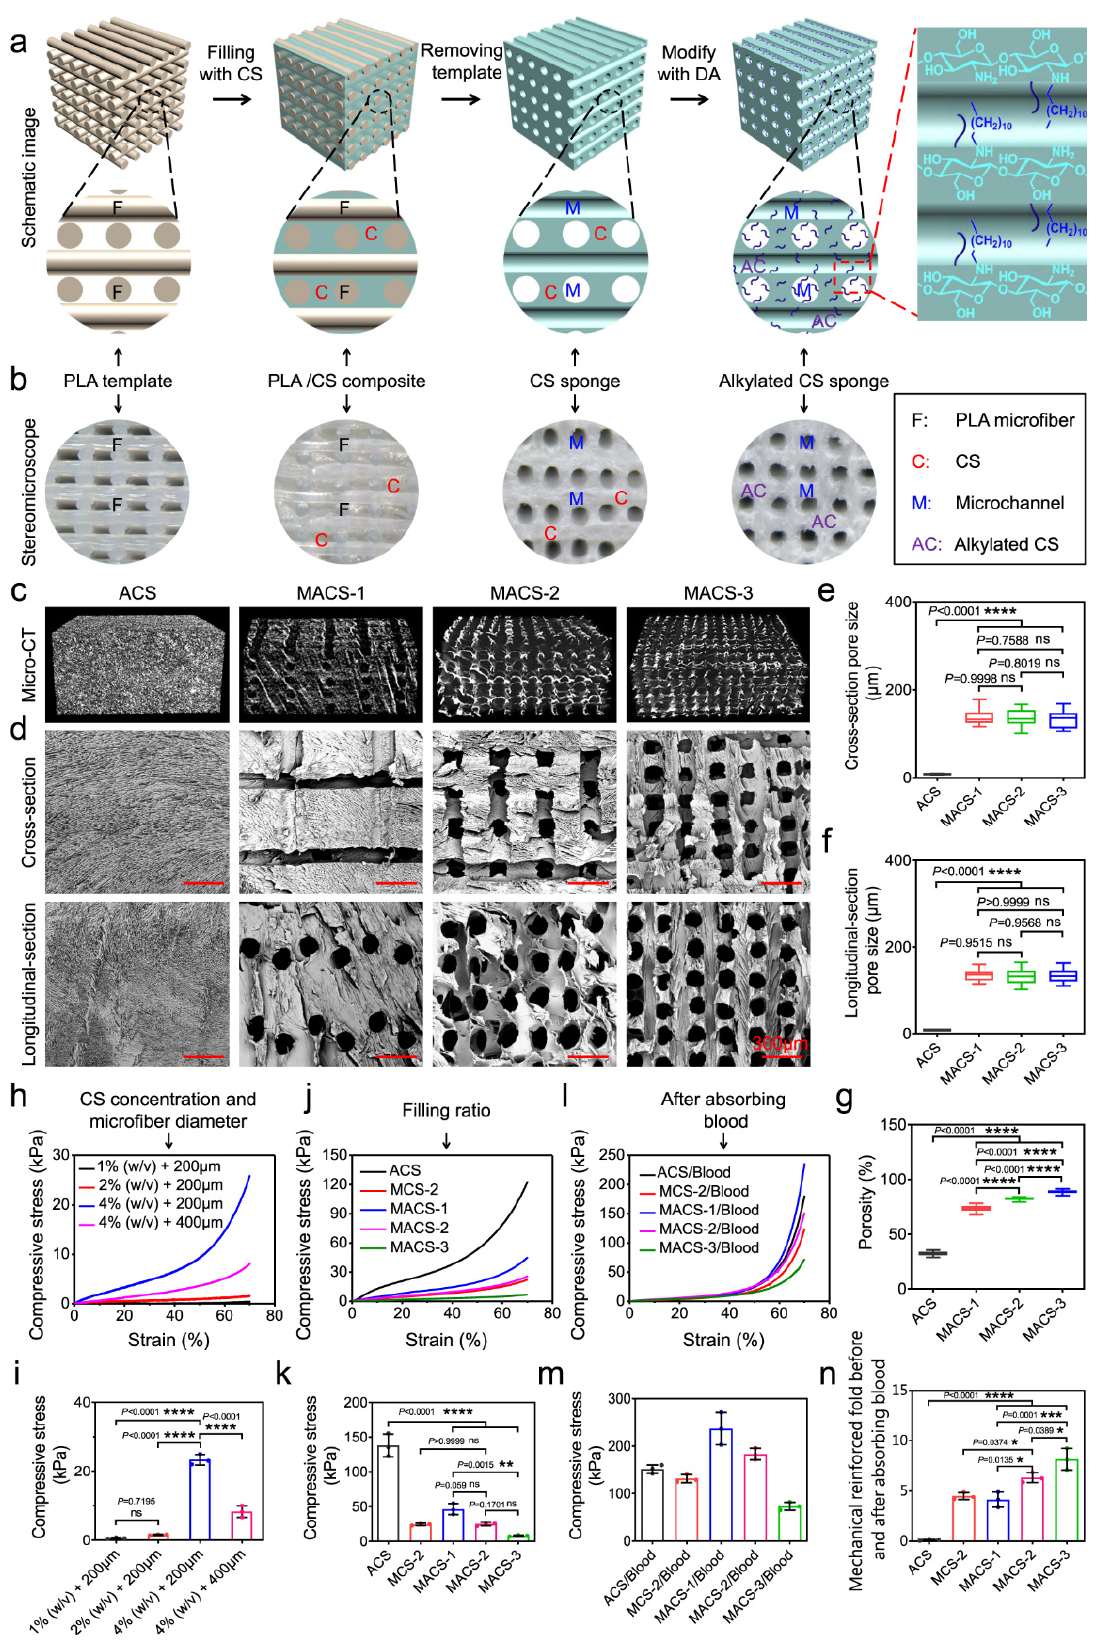
Figure 5. Fabrication and characterization of the MACS with different porosity. ( a ) Schematic illus- tration of the fabrication process of the MACSs; ( b ) Stereomicroscopic images of the PLA microfiber template, PLA composite, micro channeled chitosan sponge, and micro channeled alkylated chi- tosan sponge; ( c , d ) Micro-CT and SEM images showing the macro and microstructure of the akyl- ated chitosan and MACS-1/2/3 (the filling ratios of PLA microfiber template is 20, 40, or 60%); ( e ) The pore size of the alkylated chitosan and MACS-1/2/3 in cross-section and longitudinal-section (pore size, n = 16); ( f ) The pore size of the alkylated chitosan and MACS-1/2/3 in longitudinal-section (pore size, n = 16); ( g ) The porosity of the alkylated chitosan and MACS-1/2/3 (porosity, n = 25); ( h , i ) Compressive stress-strain curves and compressive stress of the MACSs with different CS concen- trations (1, 2, and 4% ( w/v )) and PLA microfiber diameter (200 and 400 μ m) (n = 3 independent samples); ( j – m ) Compressive stress-strain curves and compressive stress of the alkylated chitosan,